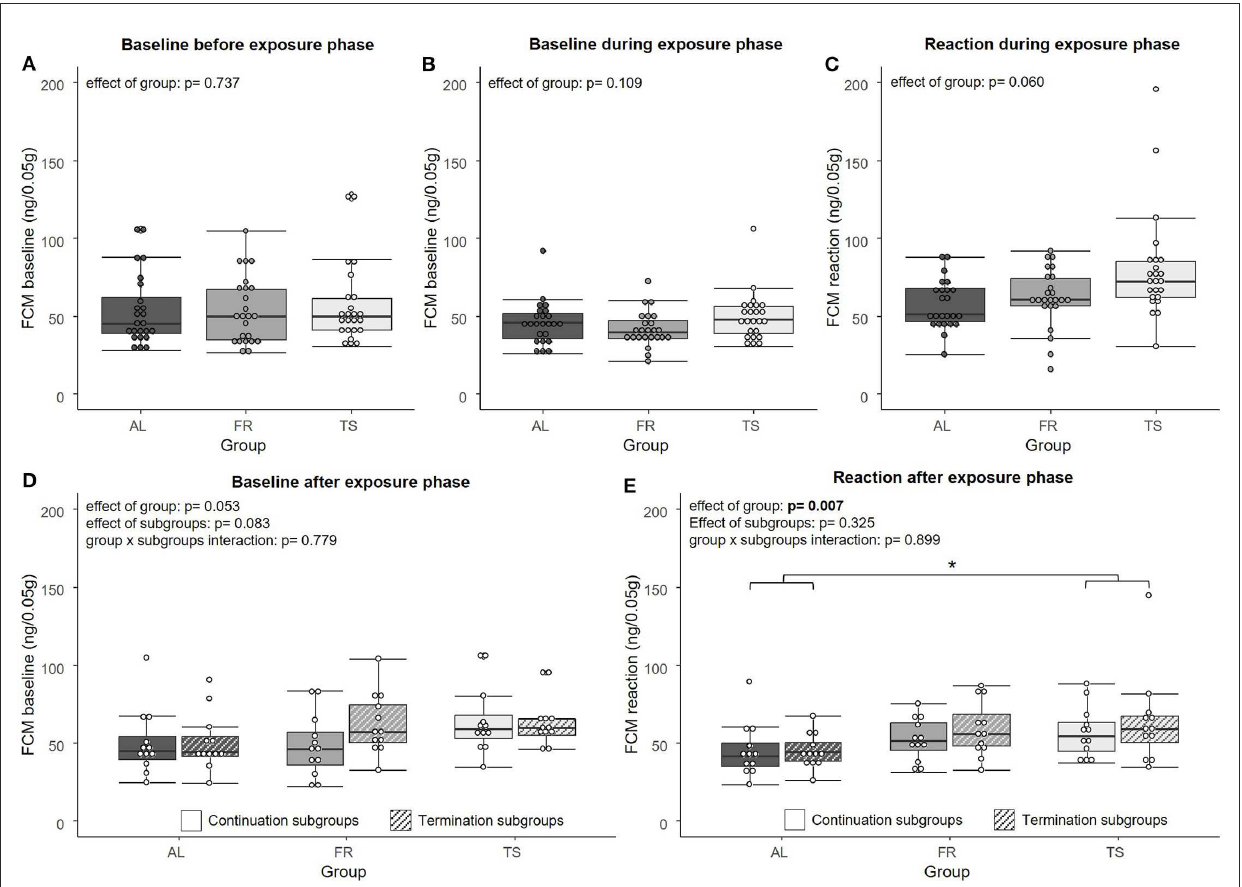
FIGURE2 Fecal corticosterone metabolites (FCMs). (A) FCM “baseline” values before the exposure phase, (B) FCM “baseline” values during the exposure phase, (C) FCM “reaction” values during the exposure phase, (D) FCM “baseline” values after the exposure phase, (E) FCM “reaction” values after the exposure phase. AL, ad libitum fed mice; FR, food restricted mice; TS, touchscreen trained mice. Sample sizes: n = 24/group for (A–C) and n = 12/group for (D, E) . Box plots show the median (lines in boxes), the 25 and 75% quartiles (boxes), the minima and maxima (whiskers) and individual data points (circles). Statistics: LMM. * p ≤